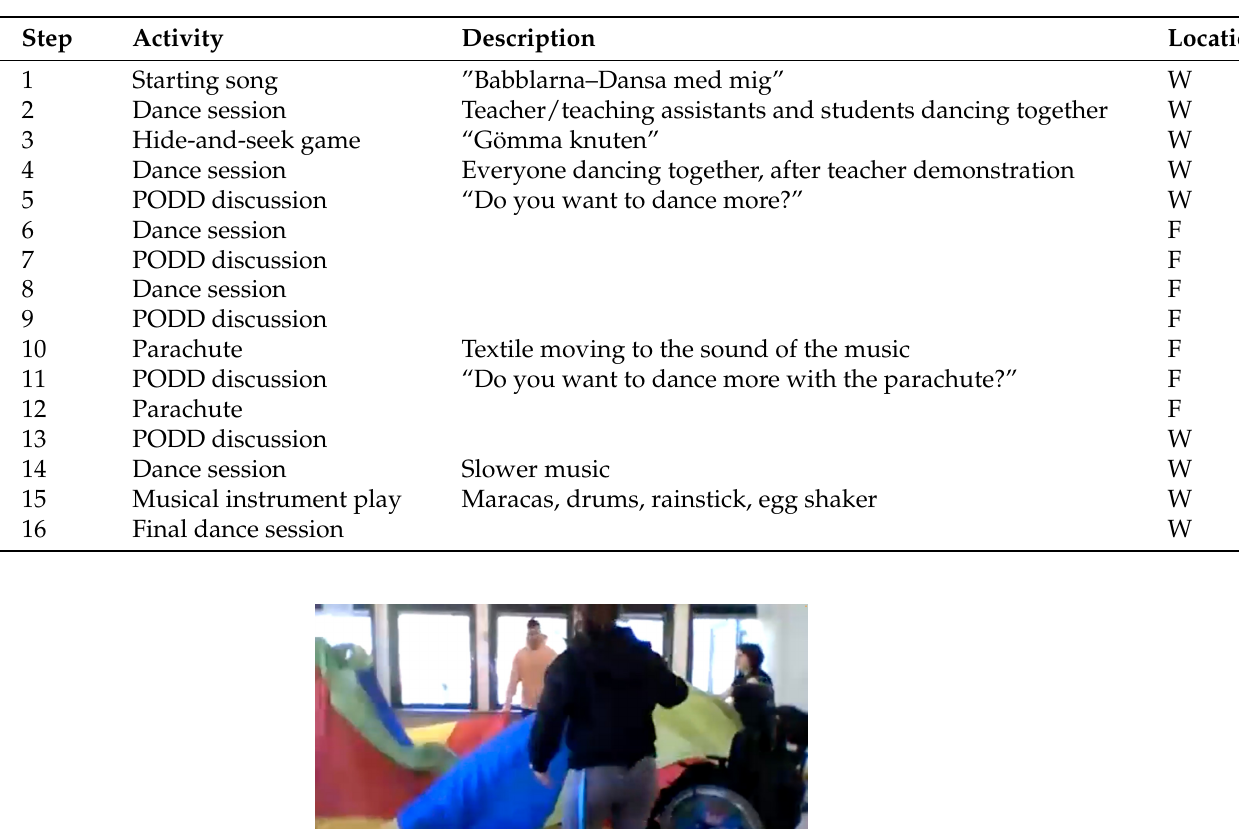
Table 2. Activities during the observed music/dance lesson, where W = wheelchair, and F = floor.